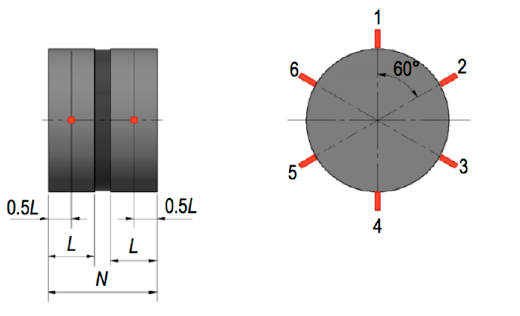
Figure 6. Example of a screen with the results of residual stress measurement. The settings of the X ‐ ray diffractometer during the measurement were based on the material characteristics of the ring and the heat treatment of the material, where the predominant martensitic structure was assumed. 3. Results and Discussion The surface integrity of the bearing rings was analyzed in terms of geometrical fea ‐ tures of the surface and residual stresses in the upper layer. Surface geometry measure ‐ ments were divided into 2D (profile) and 3D (topography) analysis, while normal re ‐ sidual stresses were distinguished from shear stresses. 3.1. Profile and Topography Measurement Results Figure 7 presents a comparison of the profile parameters Ra obtained for different samples. Since the measurement was repeated for each sample, the average results are shown. In the diagram, 3D parameter Sa is presented, too. In general, there was no sig ‐ nificant difference between 2D and 3D results, because the Sa parameter does not dis ‐ tinguish between peaks and valleys. In most of the bearing rings, the dispersion of the results was quite similar. A significant difference was seen in bearing ring O1, where 3D parameter Sa exhibited the largest dispersion of ca. 0.2 μ m. This difference was due to the